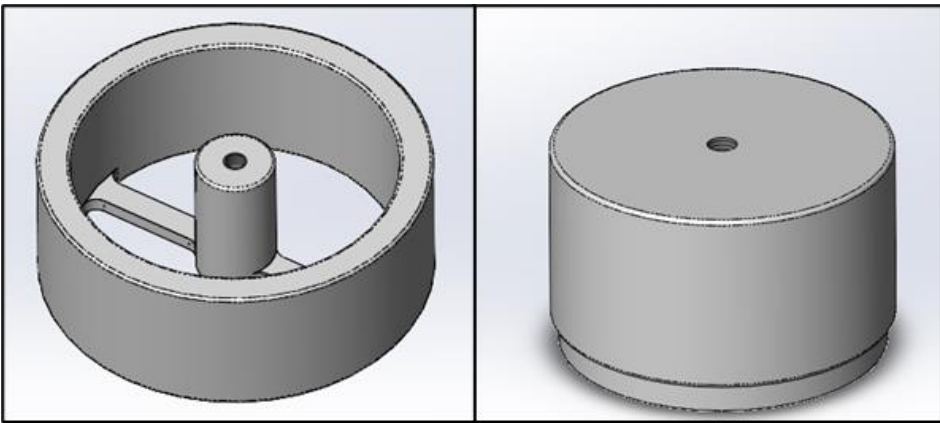
Figure 6. WCH final design: pillar 24 ( left ), pillar 48 ( right ).